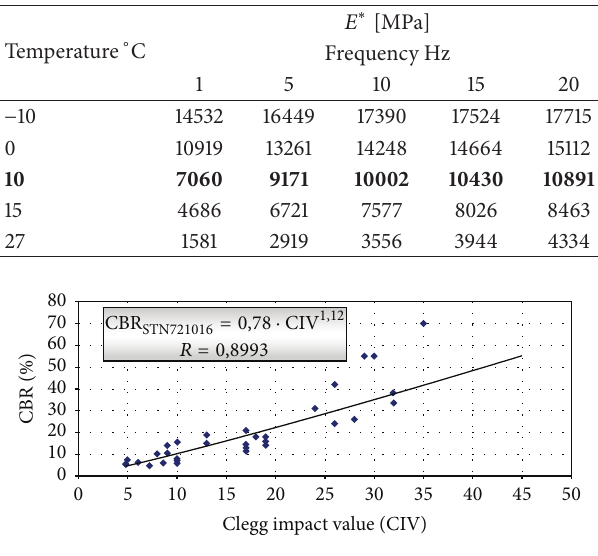
Figure 3: Clegg and CBR